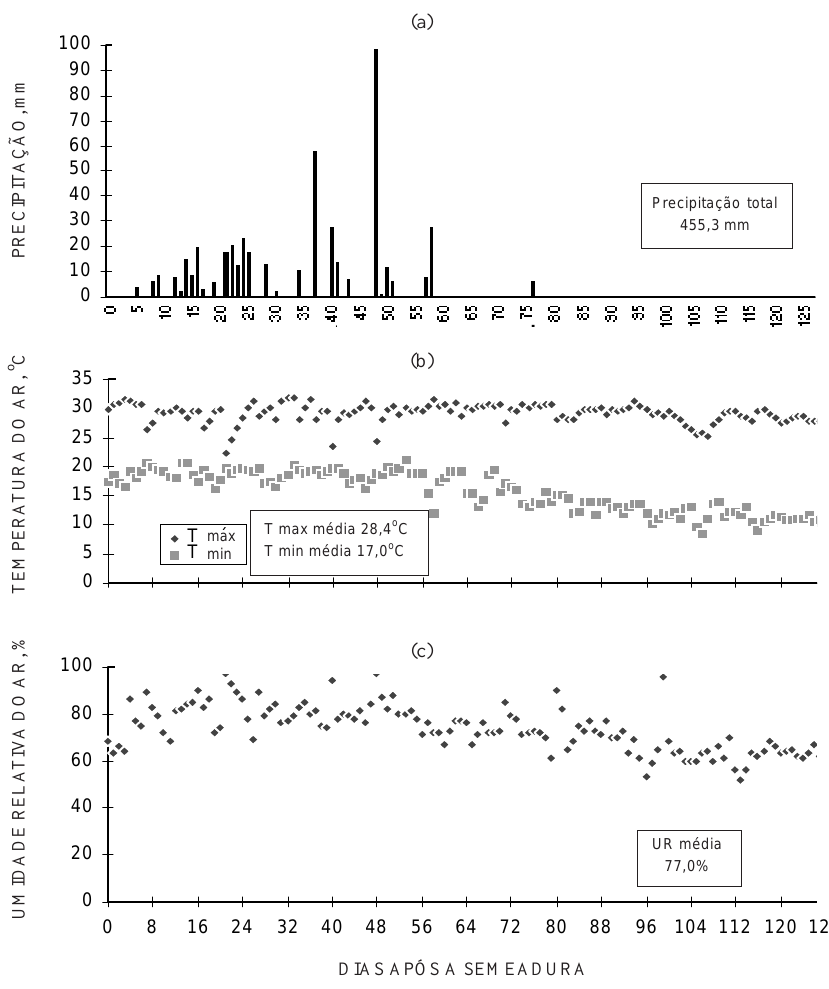
DIAS APÓS A Figura 3. Elementos do clima durante a terceira época de semeadura (4 de março de 1992): (a) precipitação (mm dia -1 ); (b) temperaturas máximas e mínimas do ar (ºC); (c) umidade relativa média do ar (%).